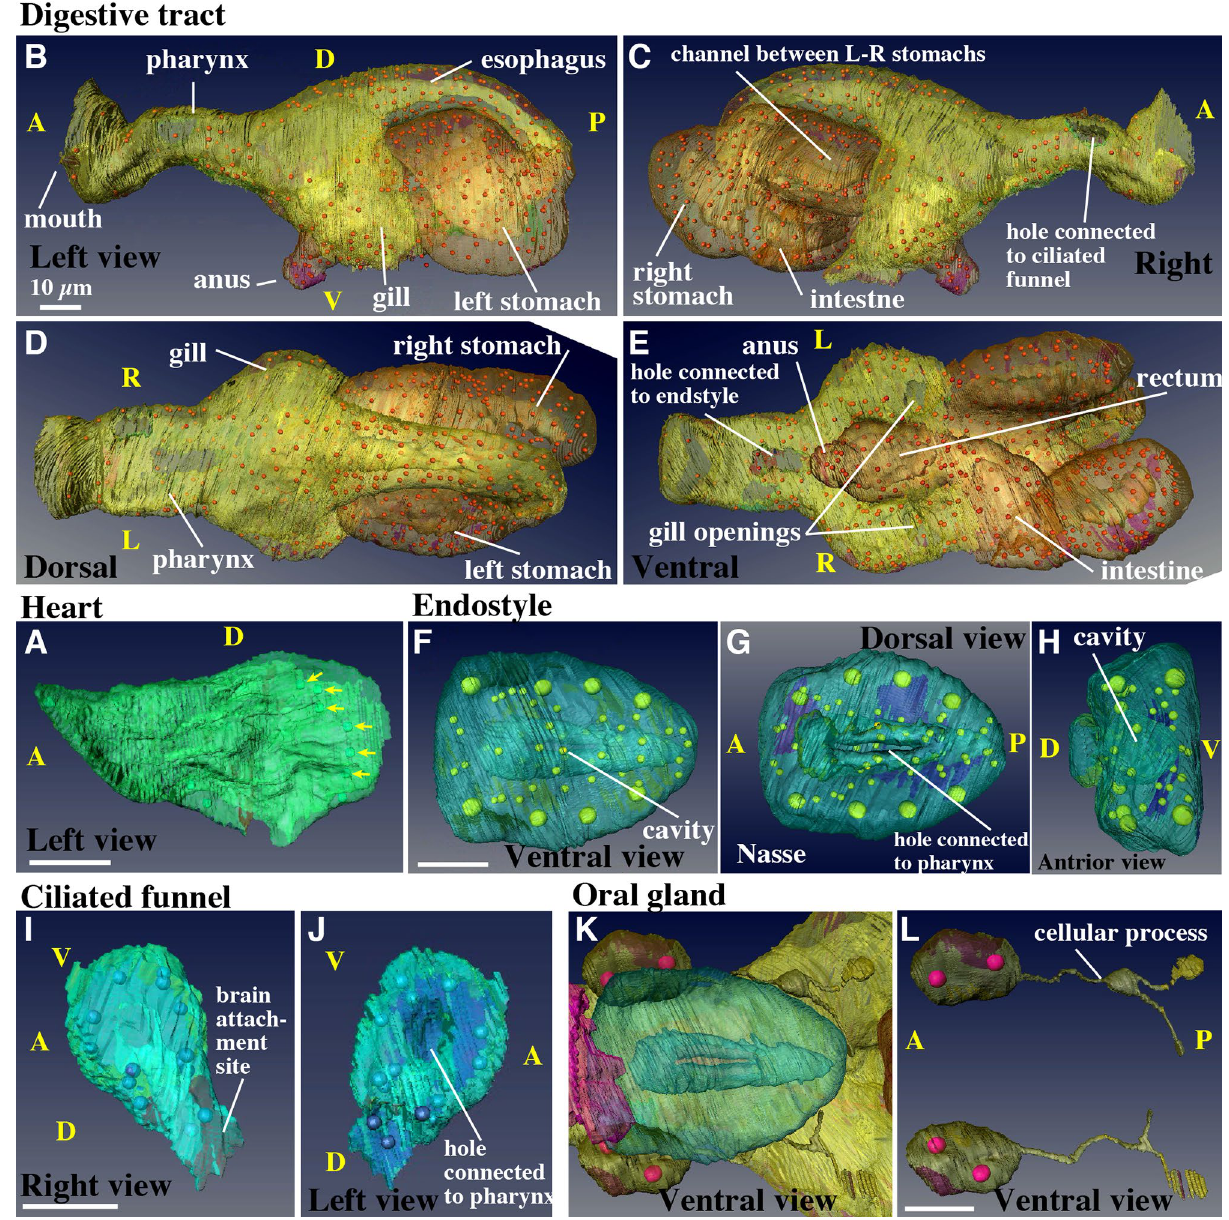
Figure 4. Mesodermal and endodermal derivatives . Note that labeling order of photos in this panel is irregular. ( A ) Heart. The muscle layer of the heart is shown in the left view. The arrows indicate the nuclei of the cardiac muscle cells. See Supplementary Movie 13. ( B–E ) Digestive tract. Seawater is filtered out through the gills, while food is passed down through the mouth, pharynx, esophagus, left stomach, the channel between the L-R stomach, the right stomach, intestine, rectum, and anus. See Supplementary Movie 15. ( F–H ) Endostyle. The cavity is connected to the pharynx shown in ( E ). See Supplementary Movie 16. ( I , J ) Ciliated funnel. The cavity is connected to the pharynx shown in C . See Supplementary Movie 17. ( K , L ) A pair of oral gland cells on both sides of the pharynx. See Supplementary Movie 18. The images were generated using the Amira software package (ver. 5 and 6). Scale bars, 10